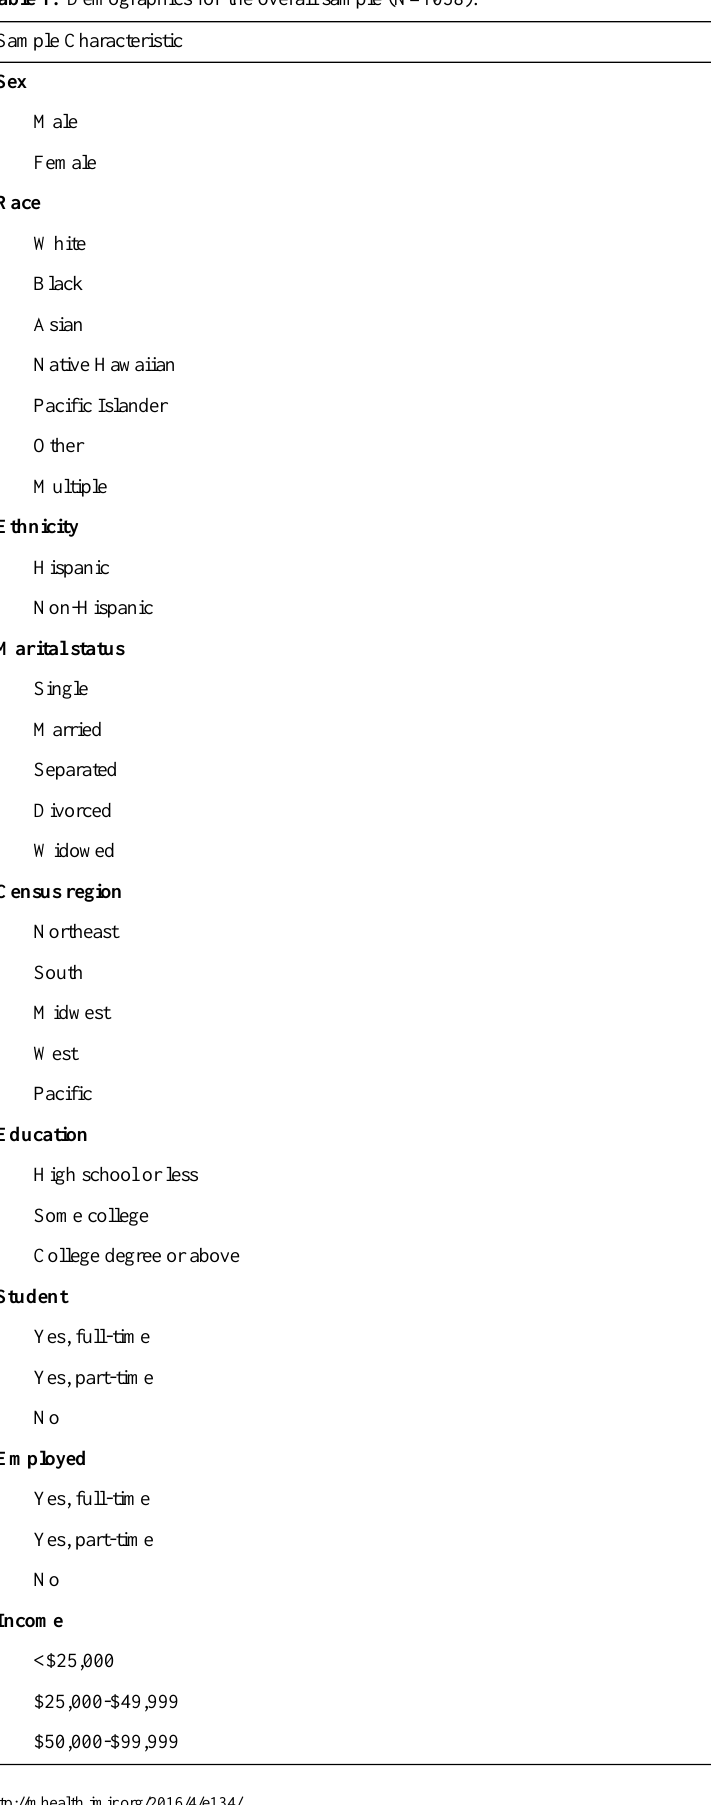
Table 1. Demographics for the overall sample